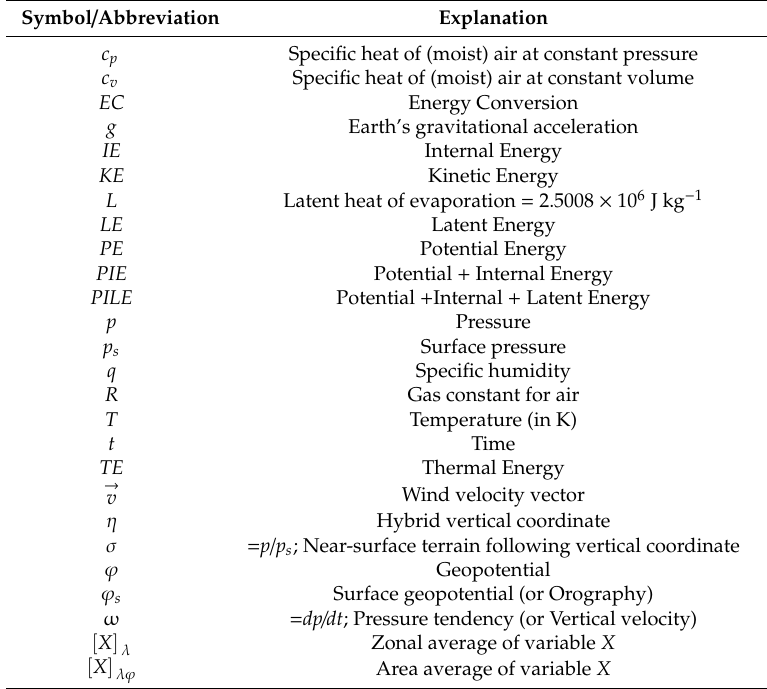
Table A1. List of symbols and